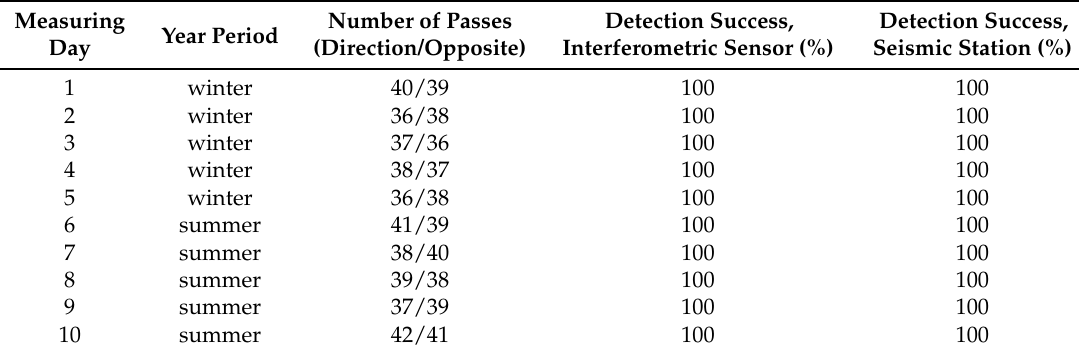
Table 2. Summary of tram vehicle detection measurements.